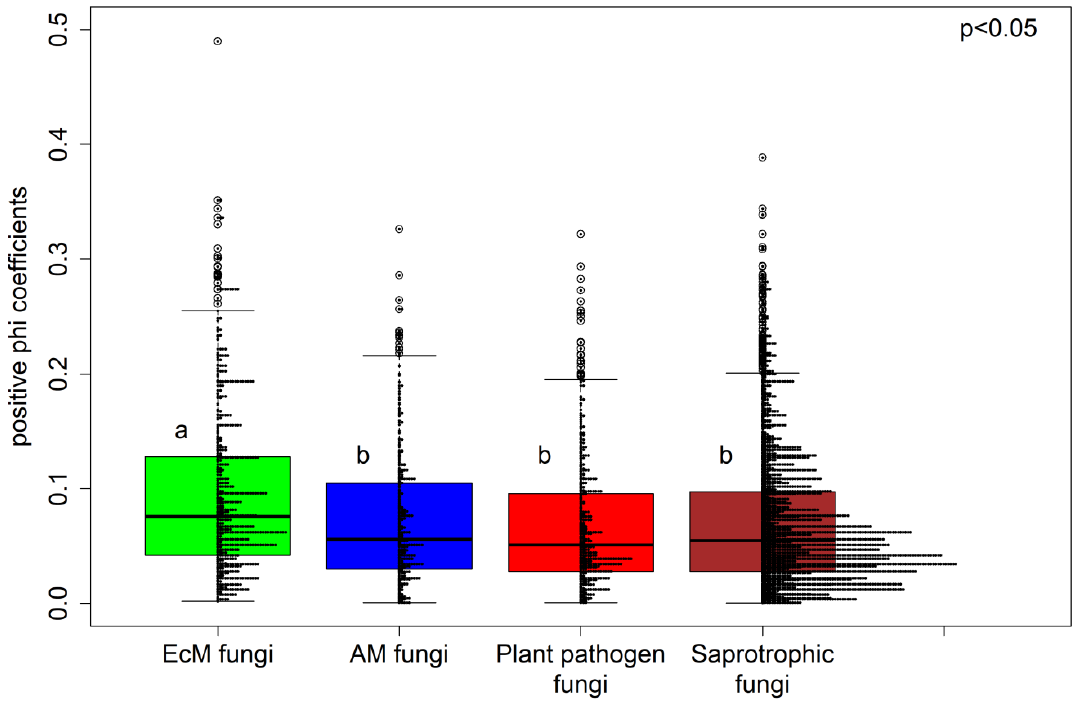
Figure 4. Boxplot showing phi specialization coe ffi cients for the main fungal functional groups, with histogram of the results of all subsampling combinations indicated as horizontal arrays; a and b indicate significantly di ff erent groups.